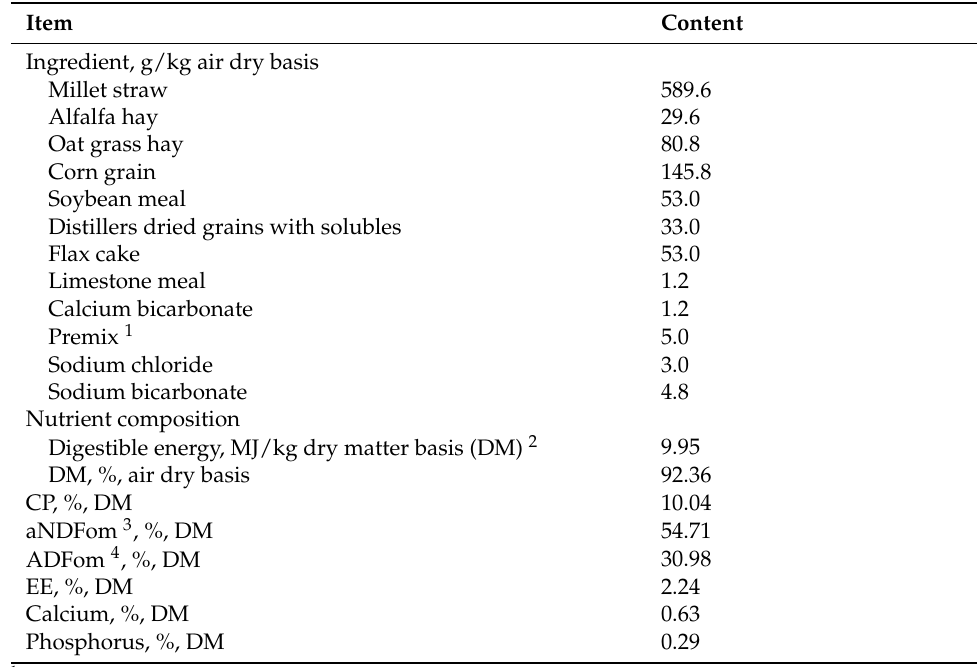
Table 2. Ingredients and nutrient composition of control